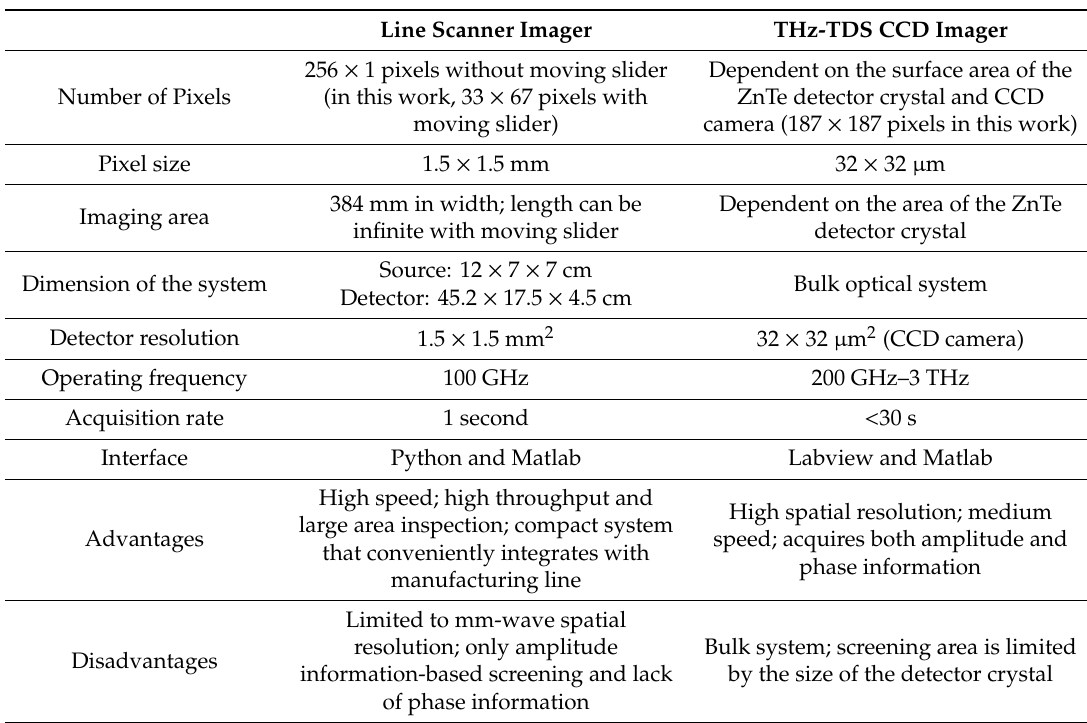
Figure 6. Calculated permittivity of the three samples at 200 GHz: ( a ) printed silver on a Teslin paper substrate without rolling treatment; ( b ) printed silver on a Teslin paper substrate with rolling treatment; ( c ) printed silver ink interdigital electrodes on a thin polyethylene film substrate. Table 1. Comparison of the two near-field scanning systems: the line scanner imager vs. the THz-TDS CCD